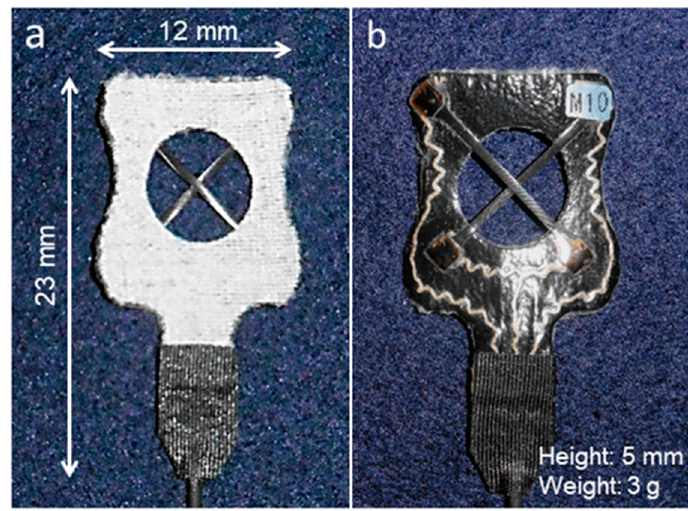
Figure 1. Measurement device developed in the study. Two carbon nanotube strain sensors were combined in a cross: ( a ) front and ( b ) back.